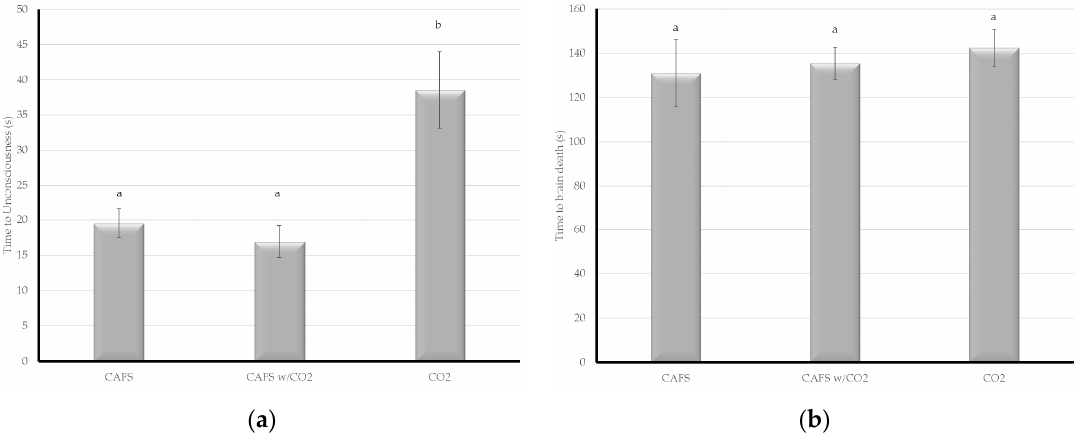
Figure 1. The time from treatment to physiological parameters during depopulation of caged layer hens under one of three treatments was evaluated. Letters within a given chart denote assigned connected letters report with differing letters representing statistical significance. ( a ) Compressed air foam systems (CAFS) and CAFS with CO 2 resulted in faster unconsciousness; ( b ) there was no statistically significant difference in time to brain death between treatments.